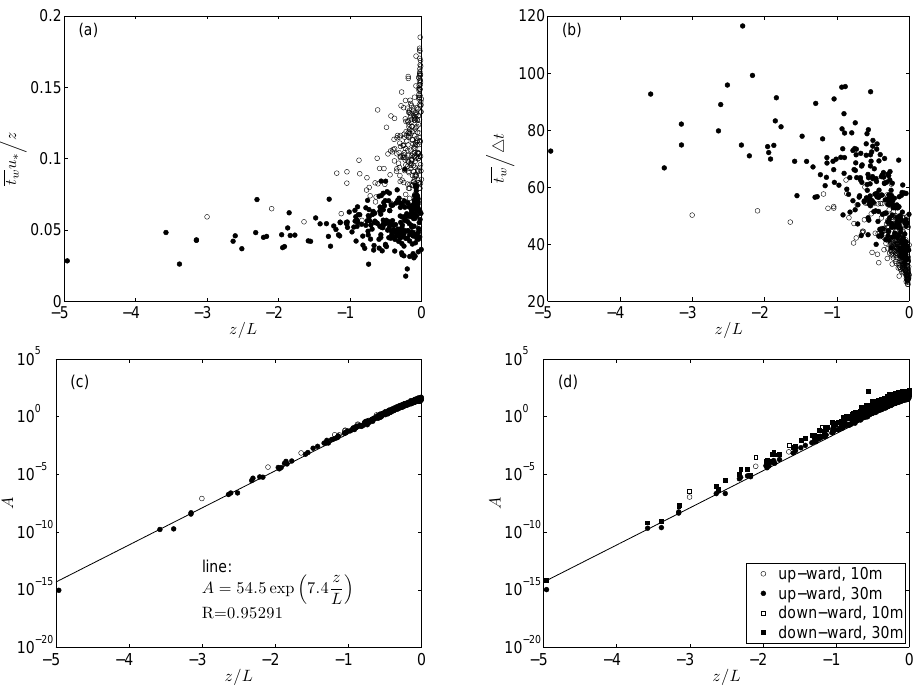
Fig. 9. Variations of dimensionless mean waiting times as a function of z/L . Filled points are measured at 30m and open ones are measured at 10m. In plots (c) and (d) , the dimensionless mean waiting time A is defined by Eq. (22). Plots (a) , (b) , and (c) show the mean waiting times in the whole extreme time series and (d) shows the mean waiting time between upward (circles) and downward (squares) extreme fluctuations separately.